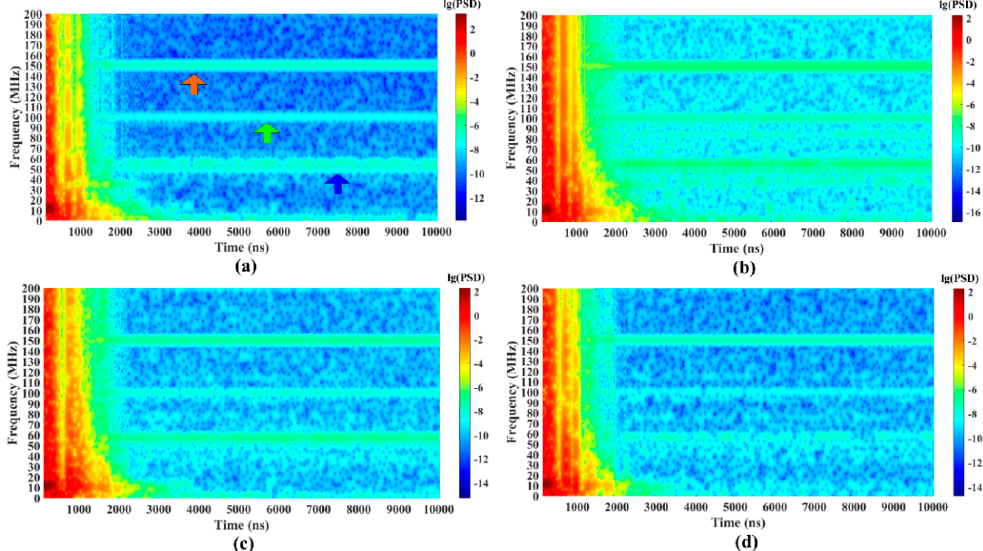
Figure 5. Time–frequency spectrum of ( a ) N104, ( b ) N106, ( c ) N202, and ( d ) N206 traces.